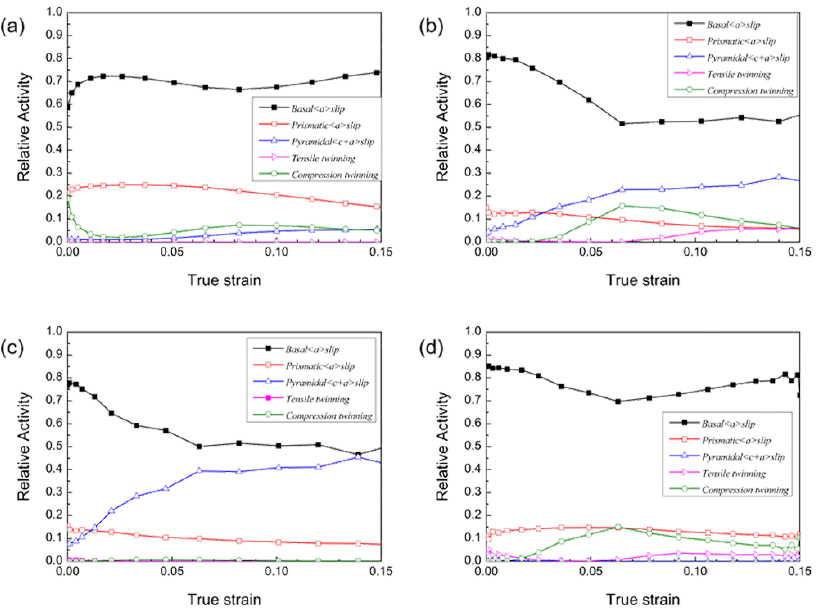
Figure 14. Selection of starting quantity of each slip system for asymmetric rolling: ( a ) SR-3.4 mm plate, ( b ) ASR-1.5 mm plate, ( c ) ASR-0.75 mm plate, and ( d ) ASR-0.5 mm plate.